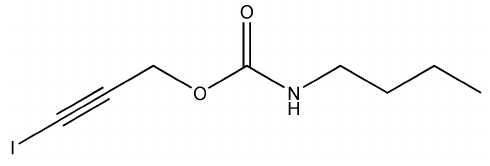
Figure 1. Molecular structure of IPBC.